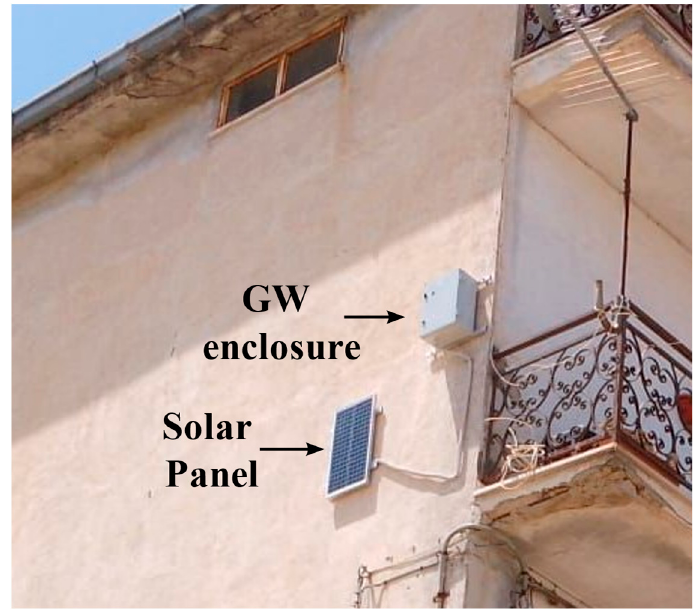
Figure 4. Gateway mounting position.